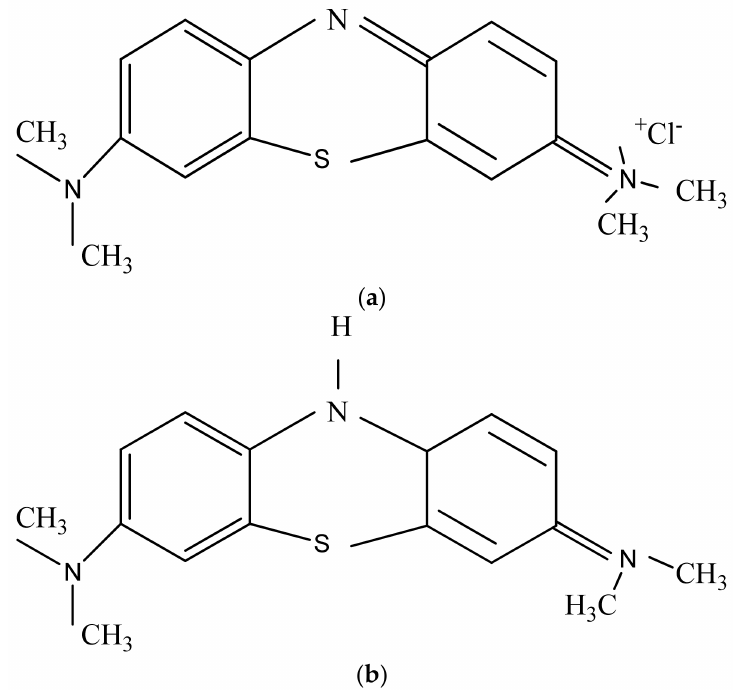
Figure 1. ( a ) MB (blue); ( b ) Leukomethylene blue